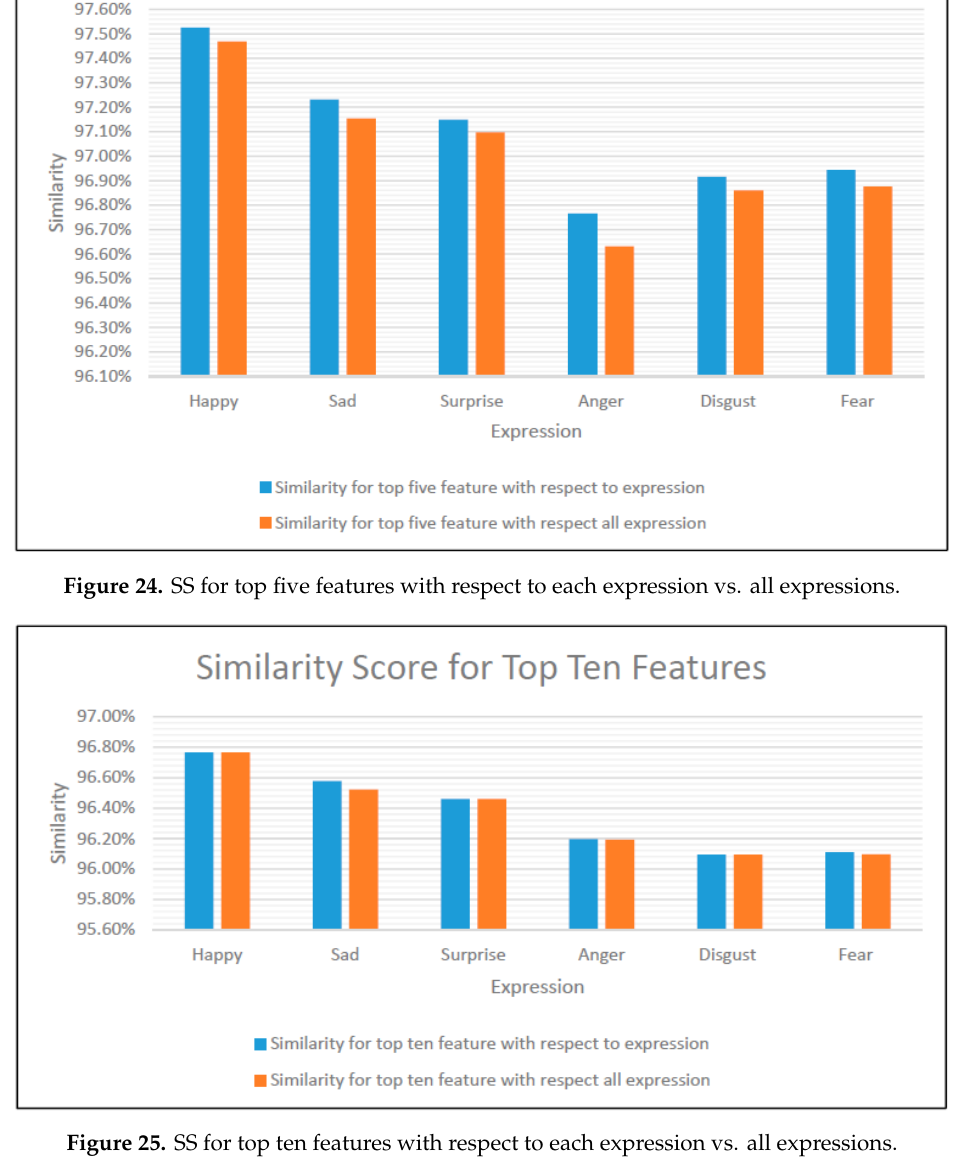
Figure 25. SS for top ten features with respect to each expression vs. all expressions.